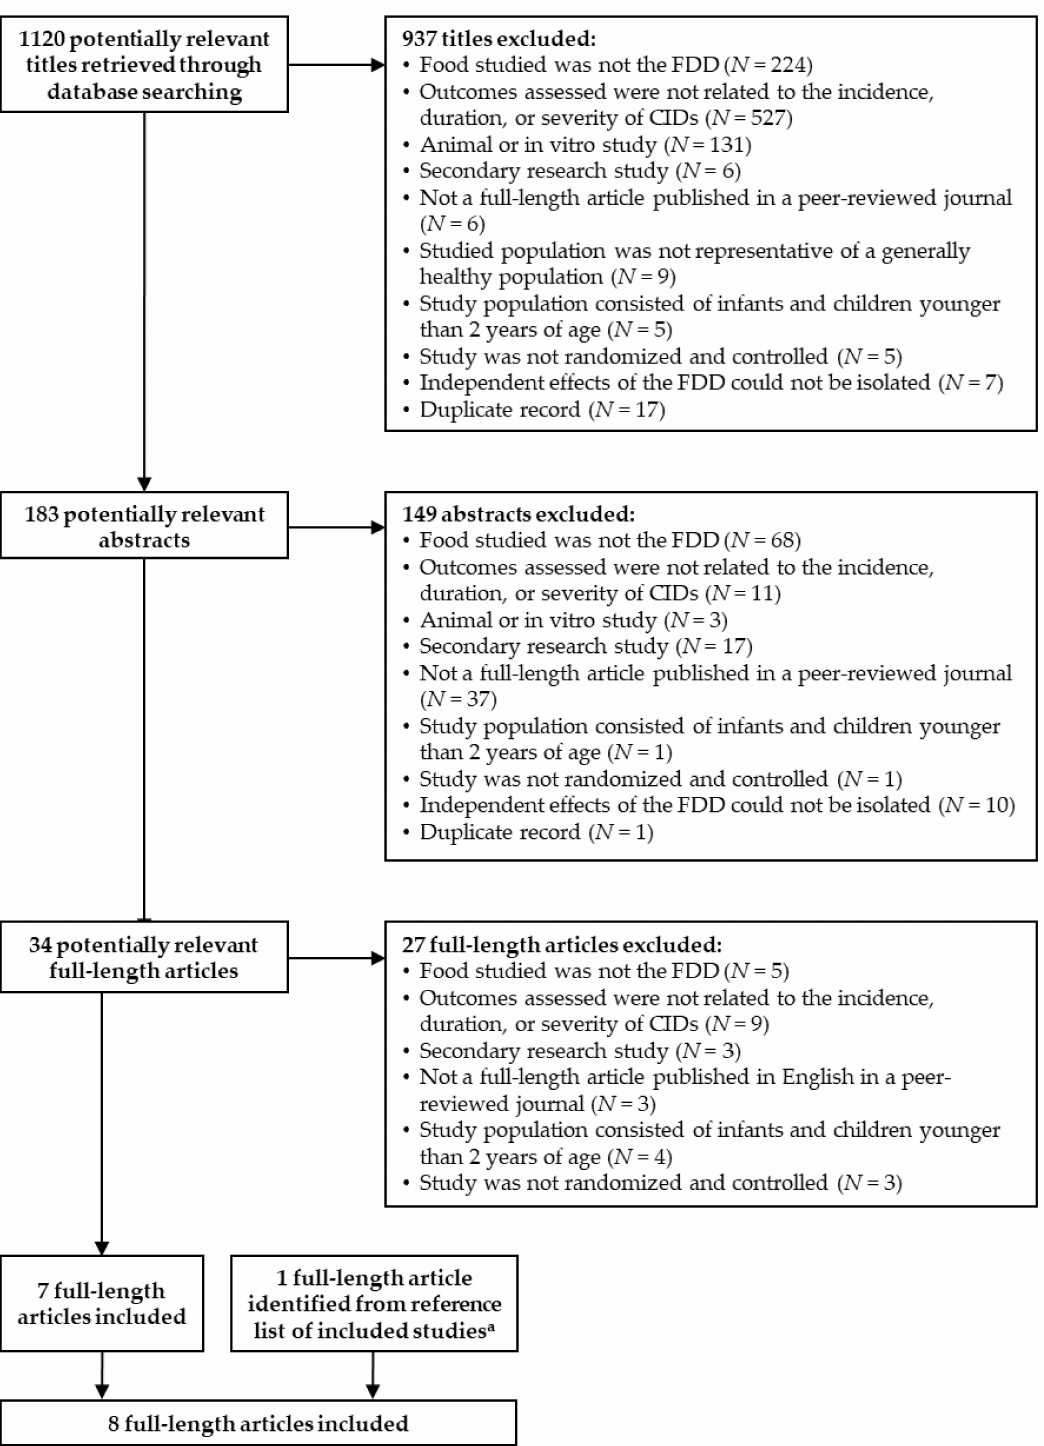
Figure 1. Flow chart of the literature search process. CID: common infection disease; FDD: fermented dairy drink containing Lacticaseibacillus paracasei subsp. paracasei CNCM I-1518 and the standard yogurt cultures. a Identified from the reference lists of the studies by Guillemard et al.